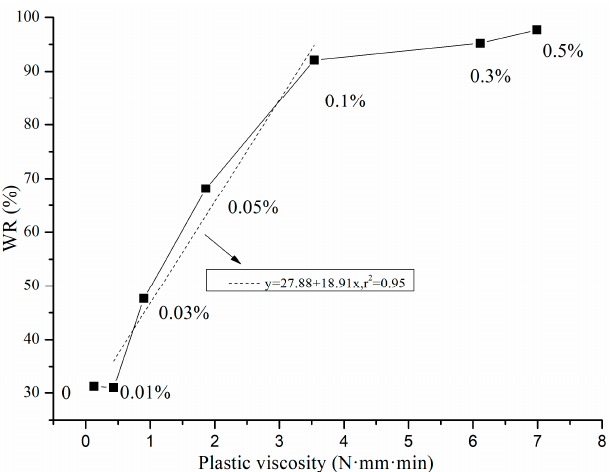
Figure 5. Relationship between plastic viscosity and water retention of cement mortar.